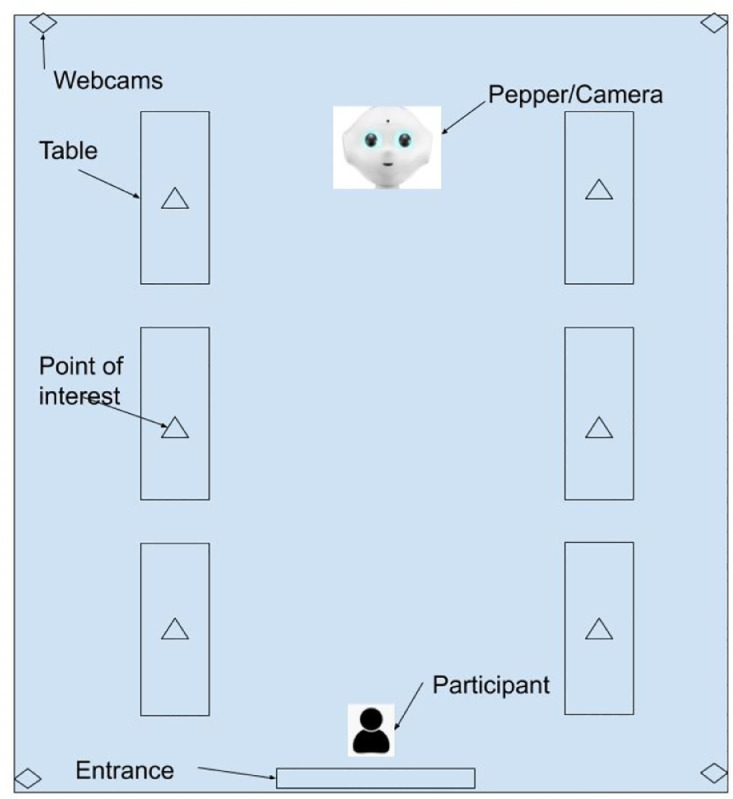
Experiment Set up.